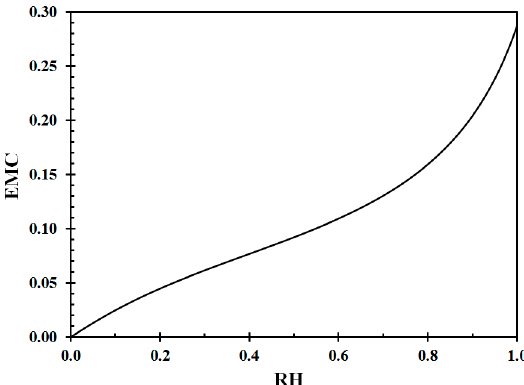
Figure A1. Equilibrium moisture content (EMC) at 22 °C as a function of relative humidity (RH). Data from Equation (A6) [44].